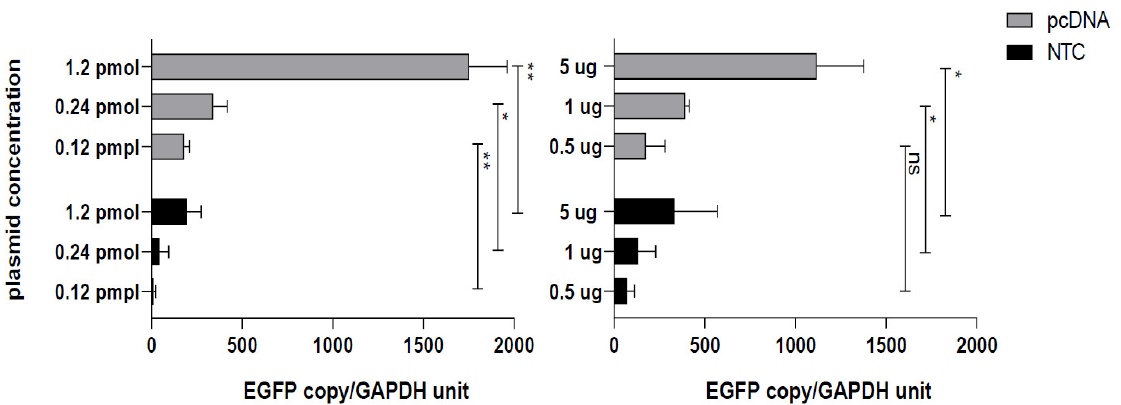
Figure 4. Quantitation of EGFP mRNA level by q-PCR . COS-7 cells transfected with NTC-EGFP or pcDNA-EGFP at equimolar (left panel) or equal concentration (right panel) were harvested 48 h post transfection for mRNA extraction. DNase treated mRNAs were subject to cDNA synthesis (100 ng as input mRNA). The relative quantities were extrapolated using standard curves obtained by EGFP and GAPDH serially diluted cDNAs. The results are representative of two separate experiments and error bars indicate the within-assay repeats in each experiment. Data were compared using Student’s t-test. * p < 0.05, ** p < 0.01. ns; non-significant.